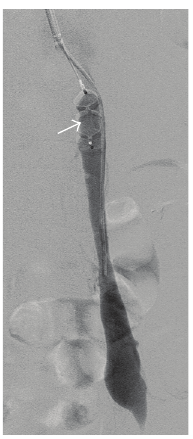
Figure 2: Venograms following selection of the left gonadal vein after Amplatzer plug deployment